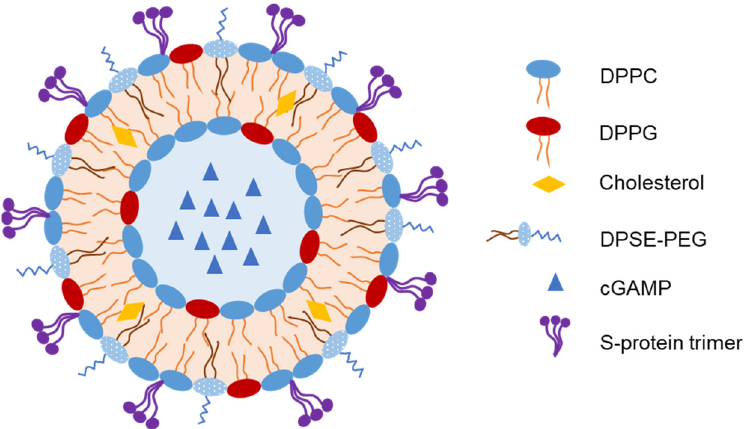
Figure 5. Representative structure of liposomes loaded with spike protein of severe acute respira- tory syndrome coronavirus 2 (SARS-CoV-2) as an intranasal (IN) vaccine [73] .